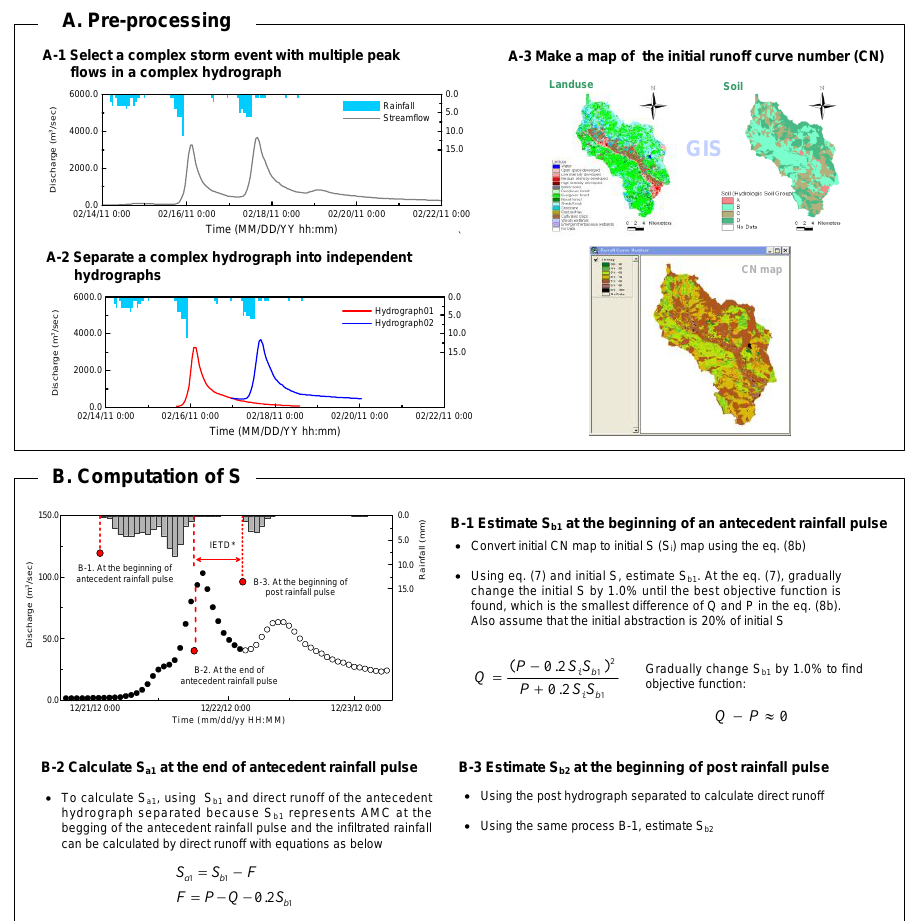
Figure 2. R-curve pre-processing steps and computation of S: ( A ) Description of each pre-processing; and, and, ( B ) Description of each progress to estimate